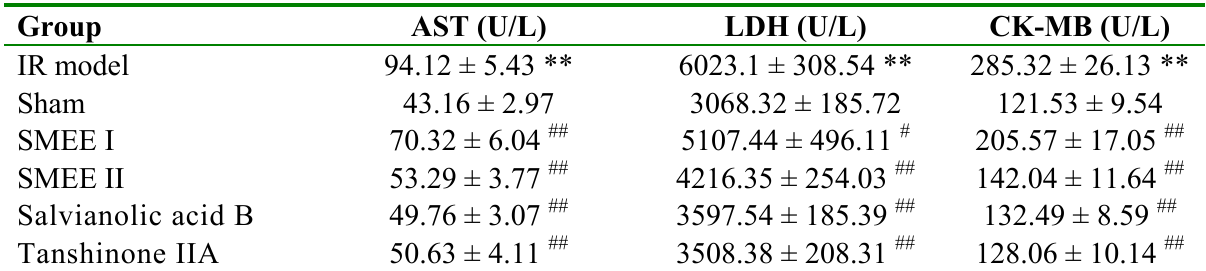
Table 3. Effect of S. miltiorrhiza ethanol extract on the serum AST, LDH and CK-MB activities.